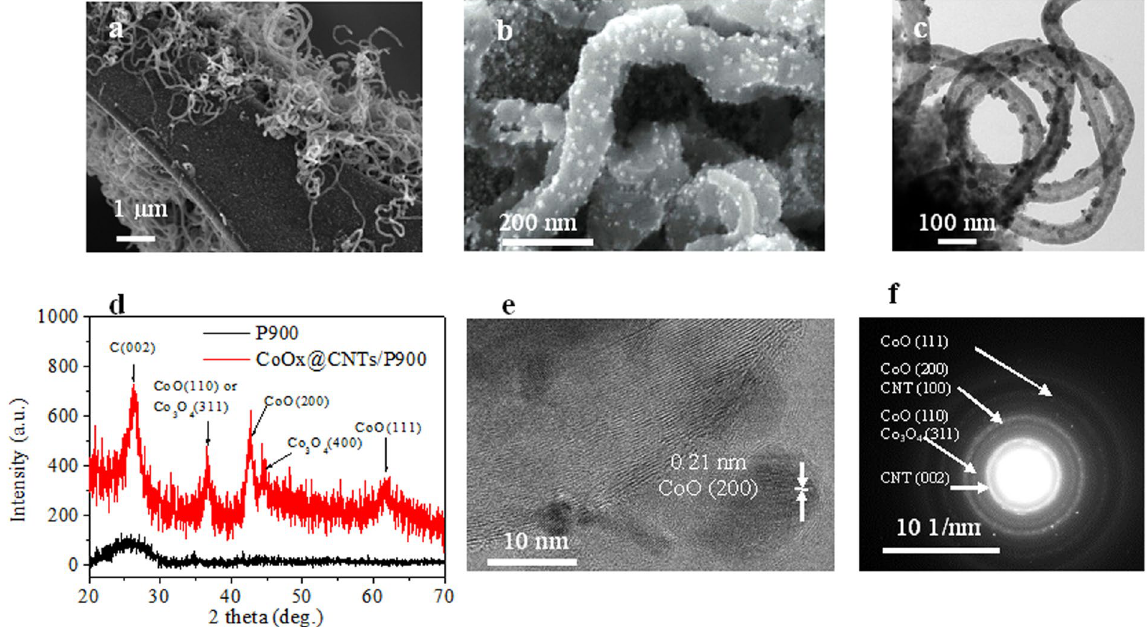
Figure 1. Structure and composition of the hierarchical carbon foam-nanotube structure decorated with CoO x nanoparticles. ( a ) Low and ( b ) high magnification scanning electron micrographs, ( c ) TEM image and ( d ) XRD patterns of P900 and CoO x @CNTs/P900 sample, ( e ) HRTEM image and ( f ) Electron diffraction pattern of ‘fresh’